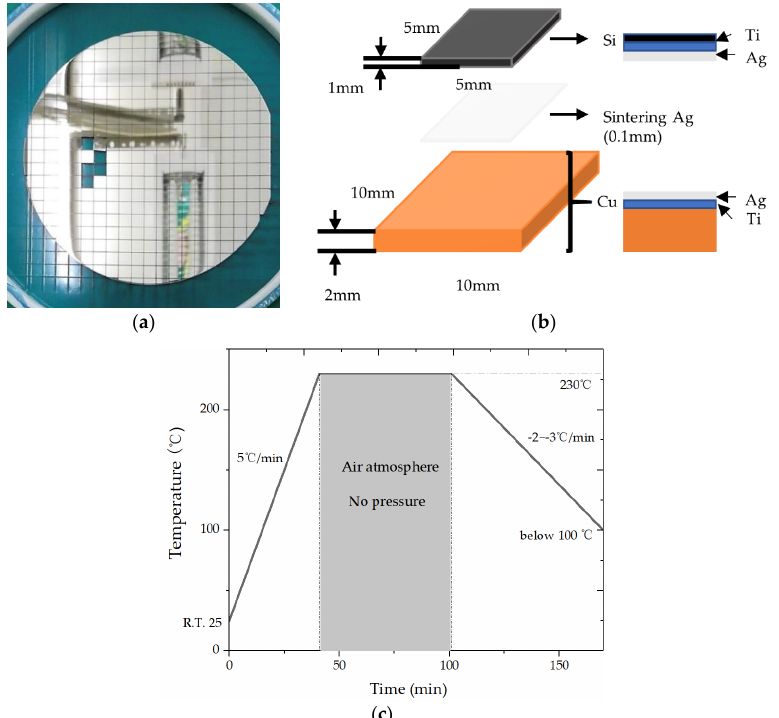
Figure 1. Details of die attachment samples: ( a ) Ti/Ag plated silicon dies; ( b ) the die attachment structure consisting of a Cu substrate, micron silver paste and one side polished die; ( c ) the curing process of micron silver joints.